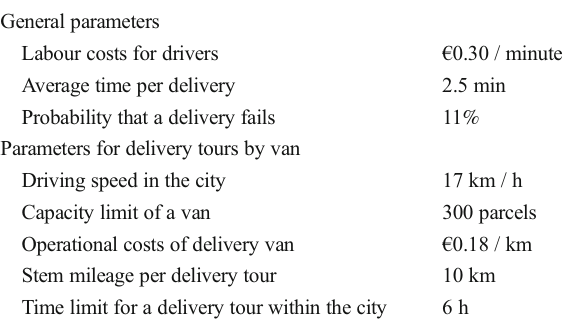
Overview of parameters to determine operational and external costs. Source: [47] General